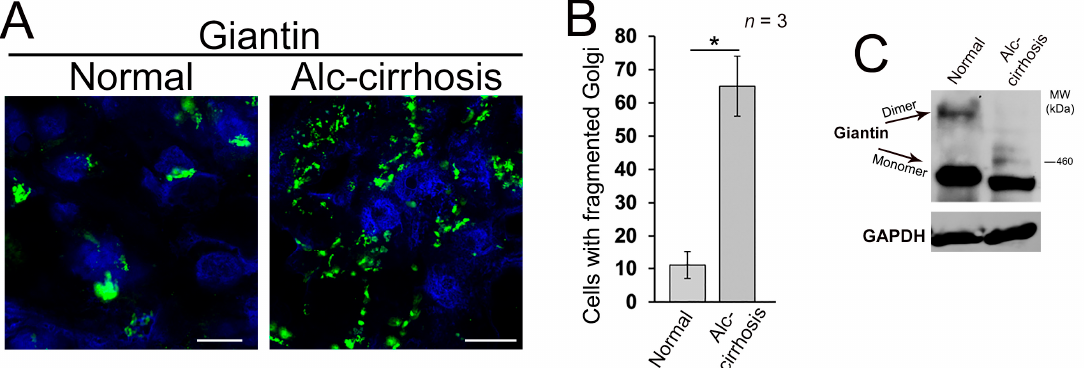
Figure 1. Alcohol-induced Golgi disorganization in patients with alcoholic liver cirrhosis. ( A ) Confocal immunofluorescence images of giantin in the liver tissue samples obtained from patients with normal liver function and patients with alcoholic liver cirrhosis; bars, 5 µ m; ( B ) Quantification of cells with fragmented Golgi; n = 3 samples for each group. Results are expressed as a mean ± standard deviation (SD); * p < 0.001; ( C ) Giantin Western blot (W-B) of lysates from samples described in ( A ). Lysates were normalized to glyceraldehyde-3-phosphate dehydrogenase (GAPDH).